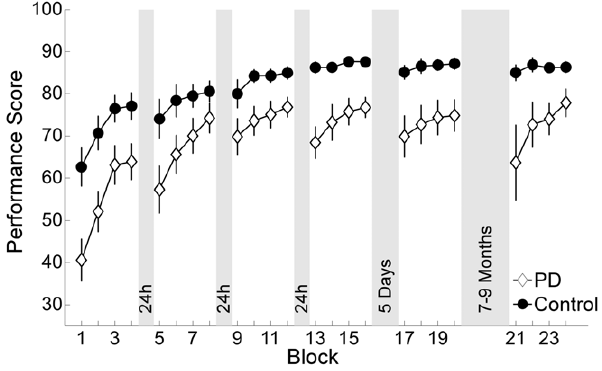
Figure 3. Performance scores over practice. Average performance over the course of five practice sessions and the retention session after 7–9 months for patients and the control group. Each session consisted of four blocks (50 trials). Note that there was a 24 hour break between the first four days and a five day break between the forth and the fifth day. Error bars denote the standard error of the